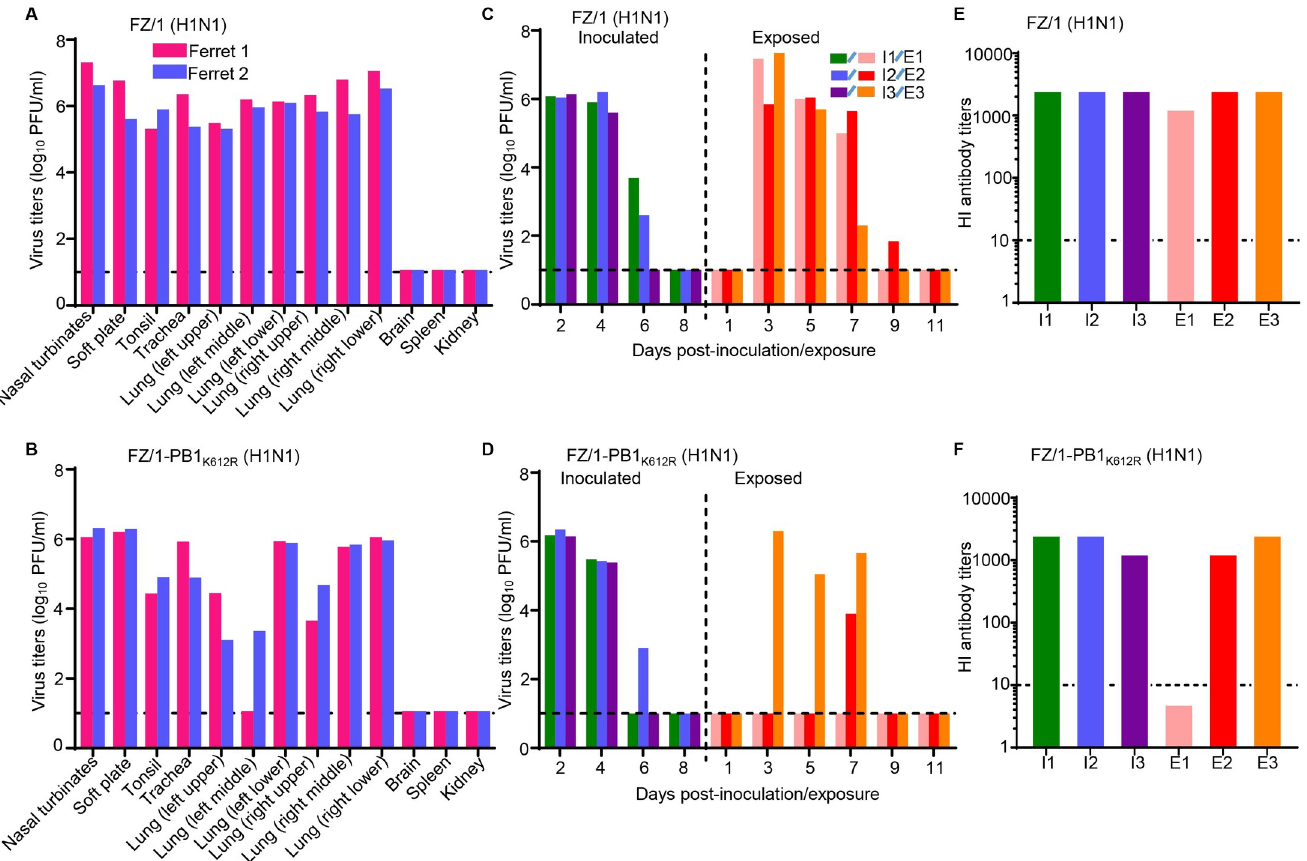
Fig 10. PB1/K612R mutation compromises the replication and respiratory droplet transmission of IAVs in ferrets. (A, B) Replication of a 2009 pandemic H1N1 virus FZ/1 and its mutant FZ/1-PB1 K612R in ferrets. Groups of two ferrets were intranasally inoculated with 10 6 PFU of FZ/1 (A) or FZ/1-PB1 K612R (B). The ferrets were euthanized on day 4 post-inoculation and the indicated organs were collected for virus titration by plaque assays. Each color bar represents the virus titer from an individual animal. (C, D) Respiratory droplet transmission of FZ/1 (H1N1) (C) and FZ/1-PB1 K612R (H1N1) (D) in ferrets. Groups of three ferrets were intranasally inoculated with 10 6 PFU of the tested virus, and 24 h later three na ï ve ferrets were introduced into the neighboring cages. Nasal washes were collected every 2 days for virus titration by plaque assays. Each color bar represents the virus titer from an individual ferret. (E, F) Seroconversion was confirmed by use of a hemagglutinin inhibition (HI) assay. Each bar represents the HI antibody titer from an individual animal. The dashed black lines indicate the lower limit of detection.